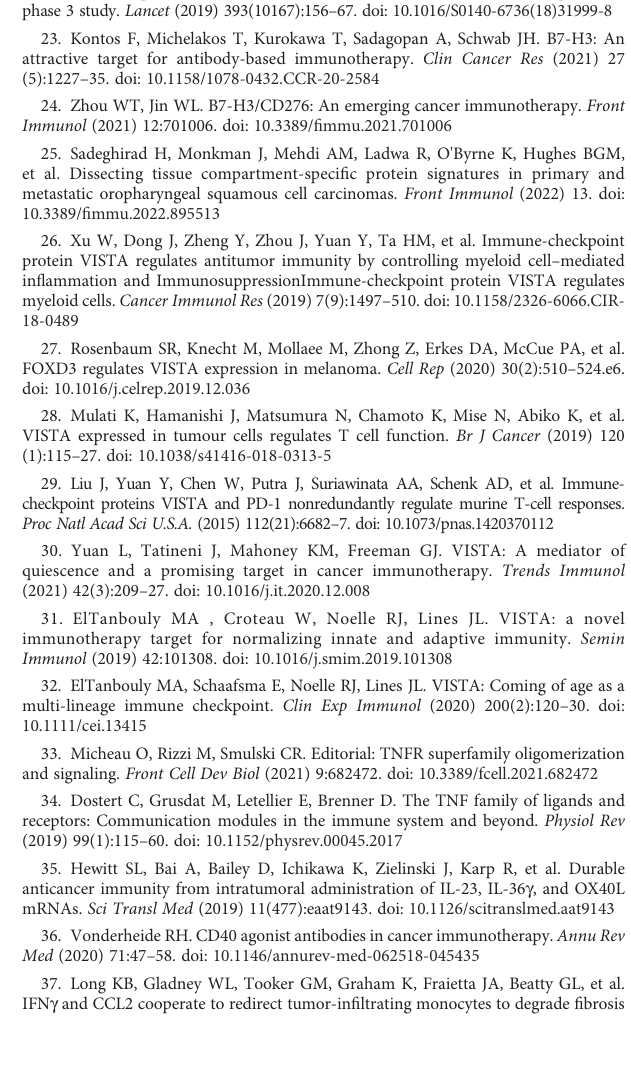
SUPPLEMENTARY FIGURE 6 Dendrogram heatmap of patients grouped by best responses in columns and protein expression in rows. (A) Dendrogram of tumor protein expression. (B) Dendrogram of stromal protein expression. Complete Response (green), Partial response (orange), stable disease (purple), progressive disease